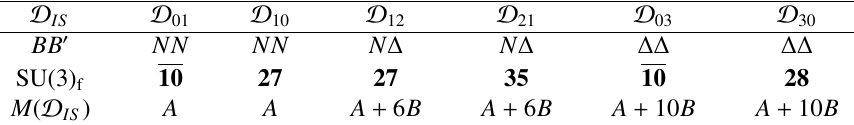
Table 1. Predicted masses of non-strange L = 0 dibaryons D IS with isospin I and spin S , using